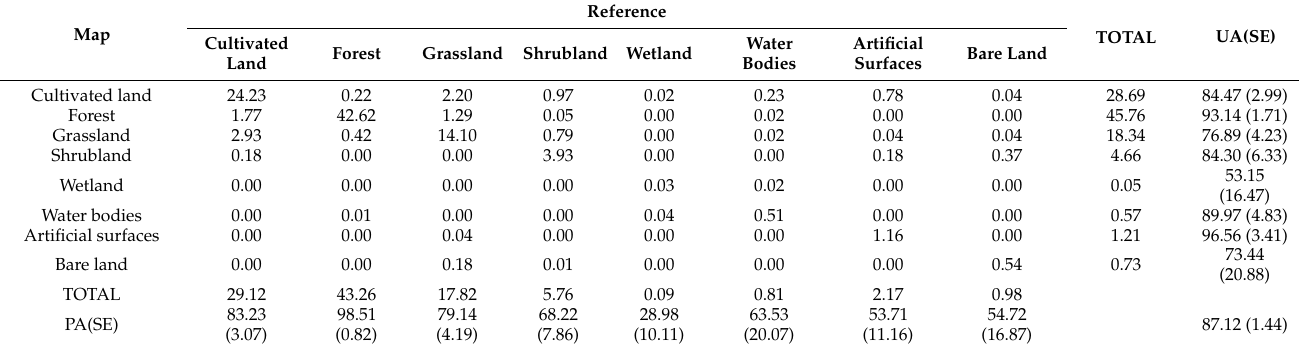
Table A13. Error matrix of fused product 2010 using localized transition